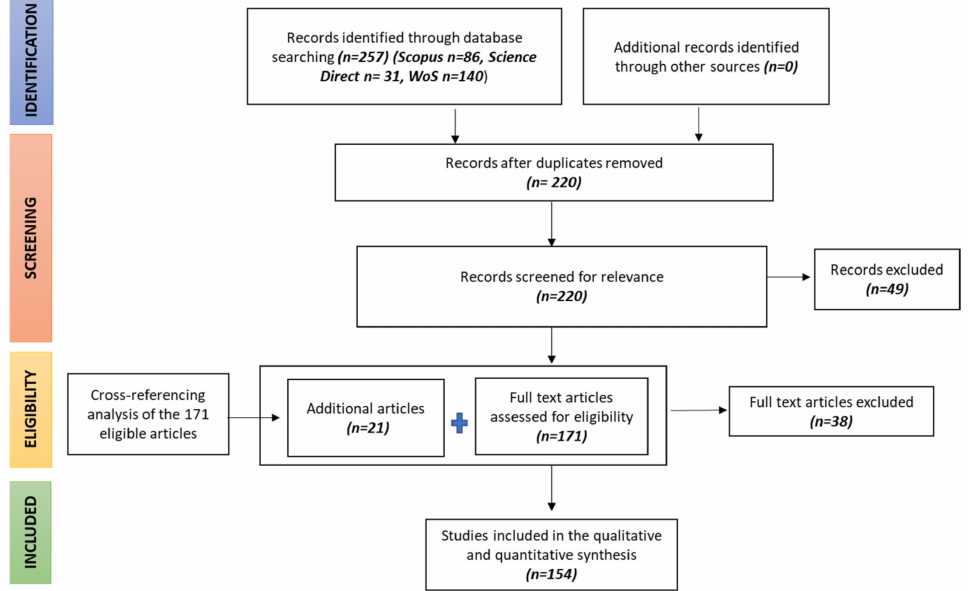
Figure 1. Flowchart of studies included in the present review ( n - the number of studies), show- ing the number of articles identified, included, and excluded through the different phases of the systematic